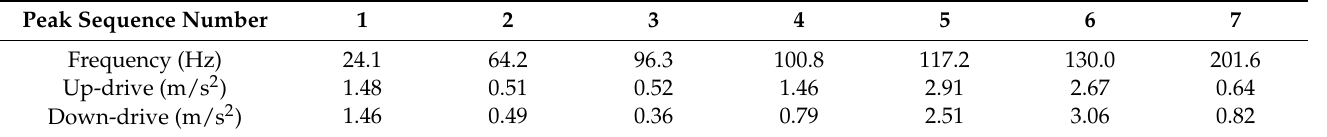
Table 3. Frequency domain peak value of vibration response at running speed of 1 m/s.